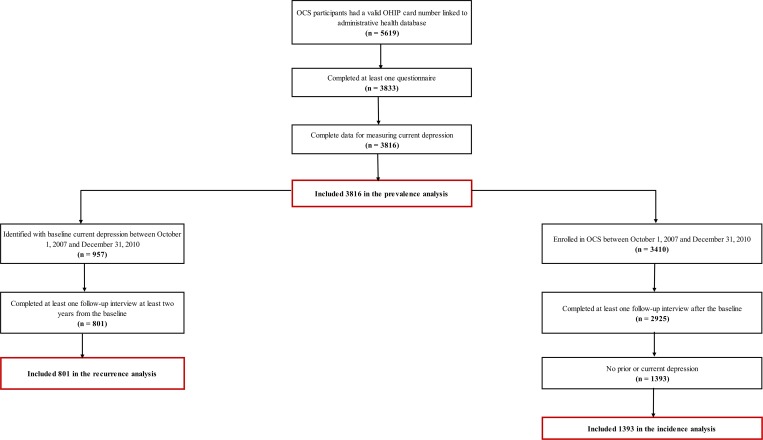
Participant Flow Chart for Development of Prevalence, Recurrence, and Incidence Cohorts.